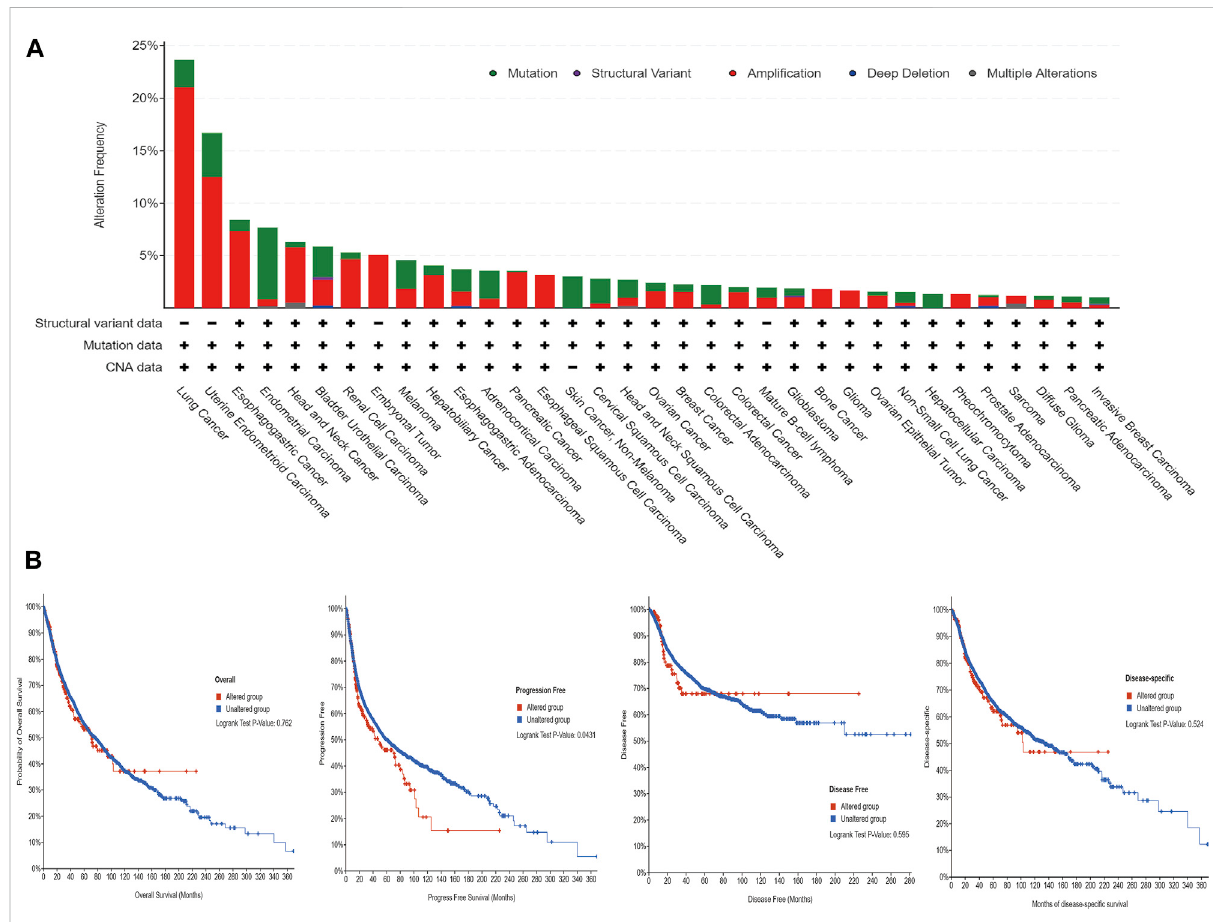
FIGURE 6 The mutational characteristics of ANLN in cancer. (A) The frequency of alterations in different types of mutations was examined using the cBioPortal database. (B) The effect of ANLN mutation status on overall survival (OS), disease-speci fi c survival (DSS), disease-free survival (DFS), and progression-free survival (PFS) of cancer patients was investigated using the cBioPortal